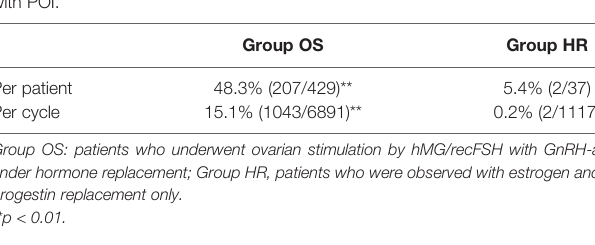
TABLE 1 | Follicle growth rate of patients in Groups OS and HR among patients with